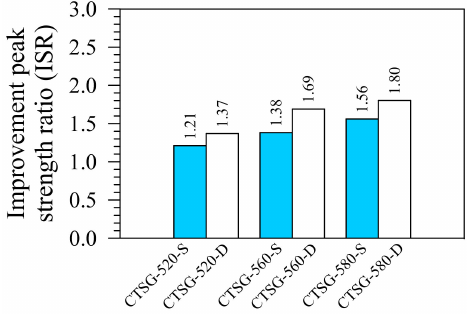
Figure 8. Improvement strength ratios.